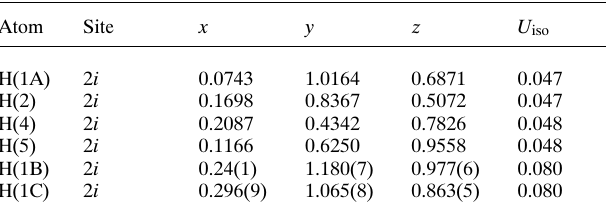
Table 2. Atomic coordinates and displacement parameters (in Å 2 )